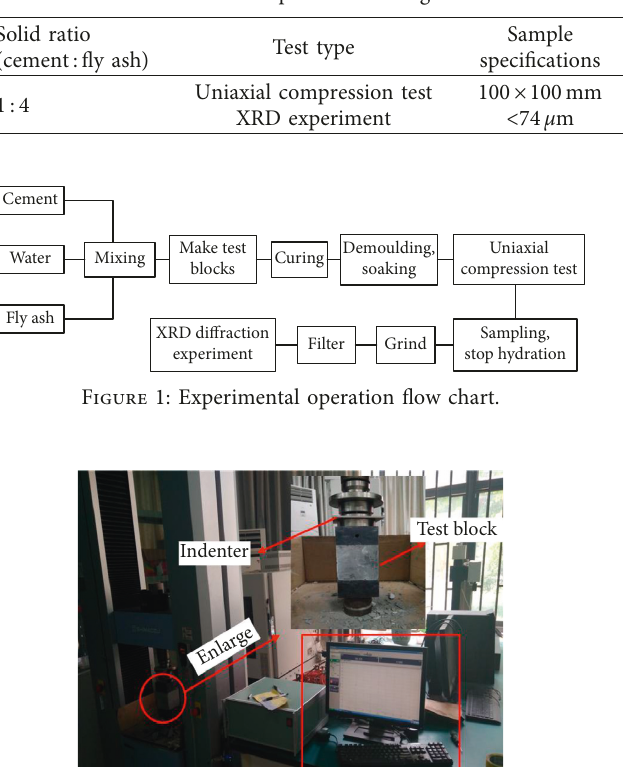
Table 4: Experimental design to determine the effect of sulfate on the durability of filling paste.